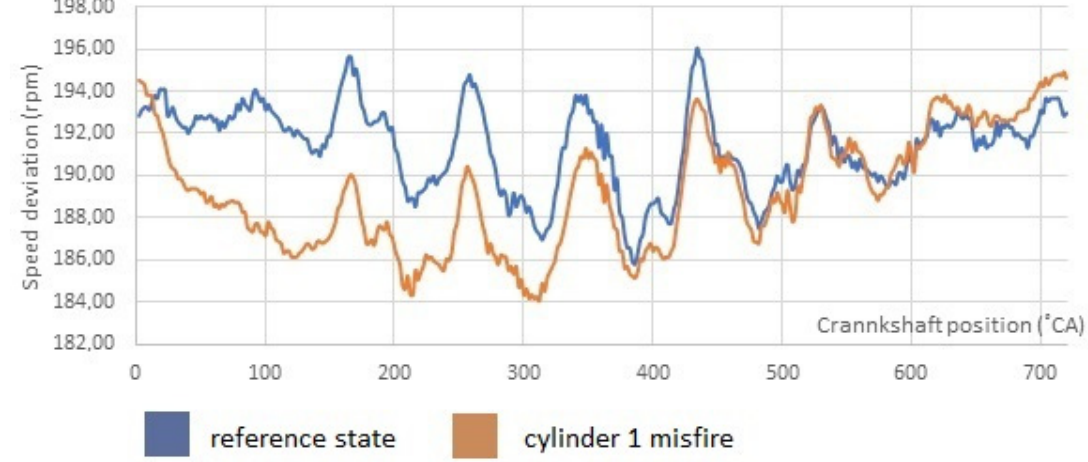
Figure 5. Reference instantaneous Buckau-Wolf R8DV-136 engine speed for the pre-set speed of 190 rpm.